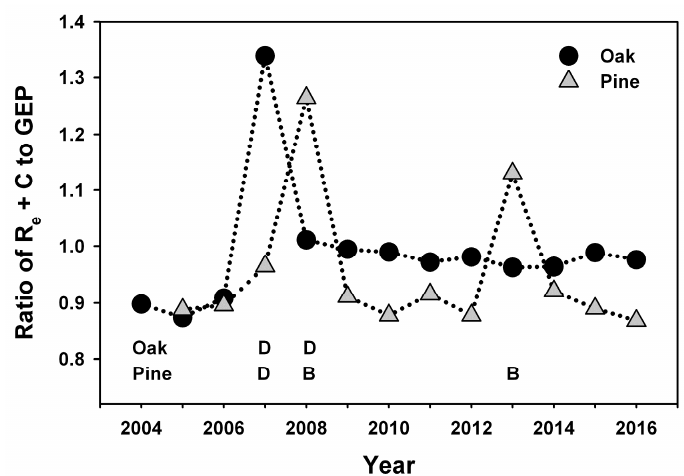
Figure 2. Ratio of ecosystem respiration (R e ) and combustion losses during prescribed burns (C) to gross ecosystem production (GEP) at the oak and pine stands by year. “D” indicates defoliation by gypsy moth and “B” indicates prescribed burns.